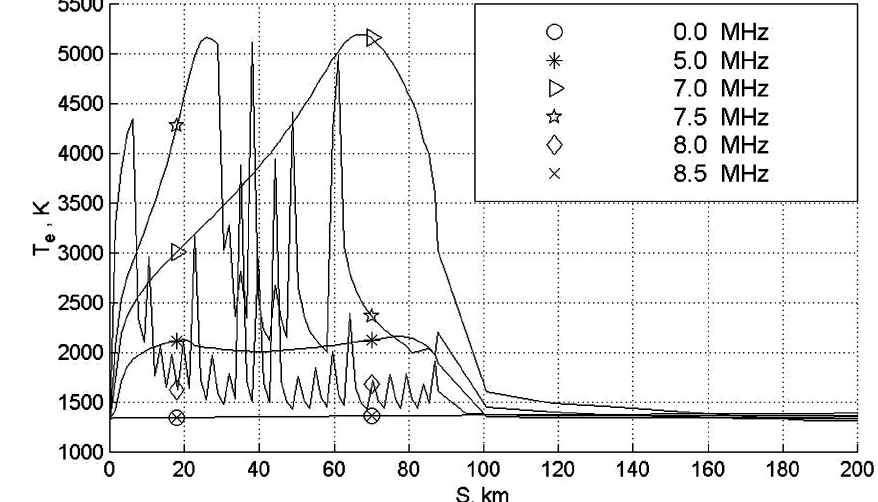
Fig. 12. The variations of the electron temperature (in absolute degrees) along the considered part of the convection trajectory at the level of 260km. The results are given for different HF wave frequencies: 5.0, 7.0, 7.5, 8.0, and 8.5MHz. The results, obtained under natural conditions without a powerful HF wave effect, are indicated by symbol 0MHz. The distance from the beginning of the illuminated region S (in km) at level h = 300km is shown on the horizontal axis. The center of the illuminated region, where the EAP achieves the maximal value, is located at S ≈